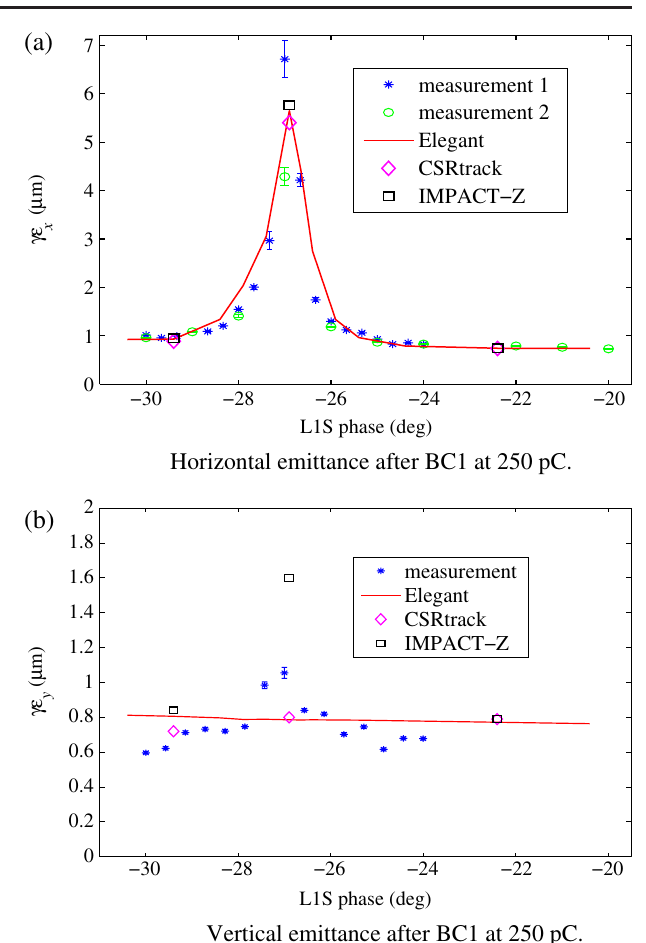
FIG. 5. (Color) Measured and simulated transverse emittances after BC1 vs L1S phase. (a) Horizontal emittance after BC1 at 250 pC. (b) Vertical emittance after BC1 at 250